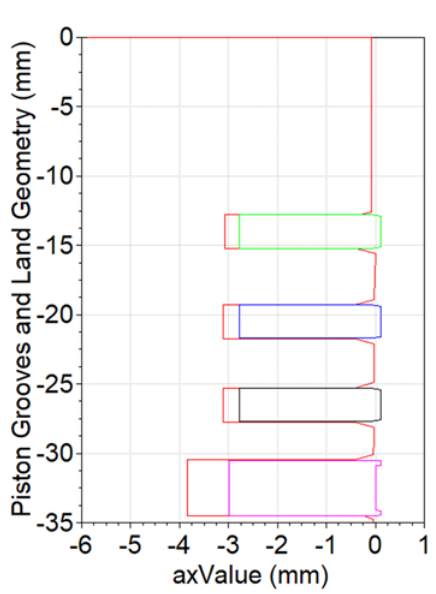
Fig. 3. Relative position of piston ring and